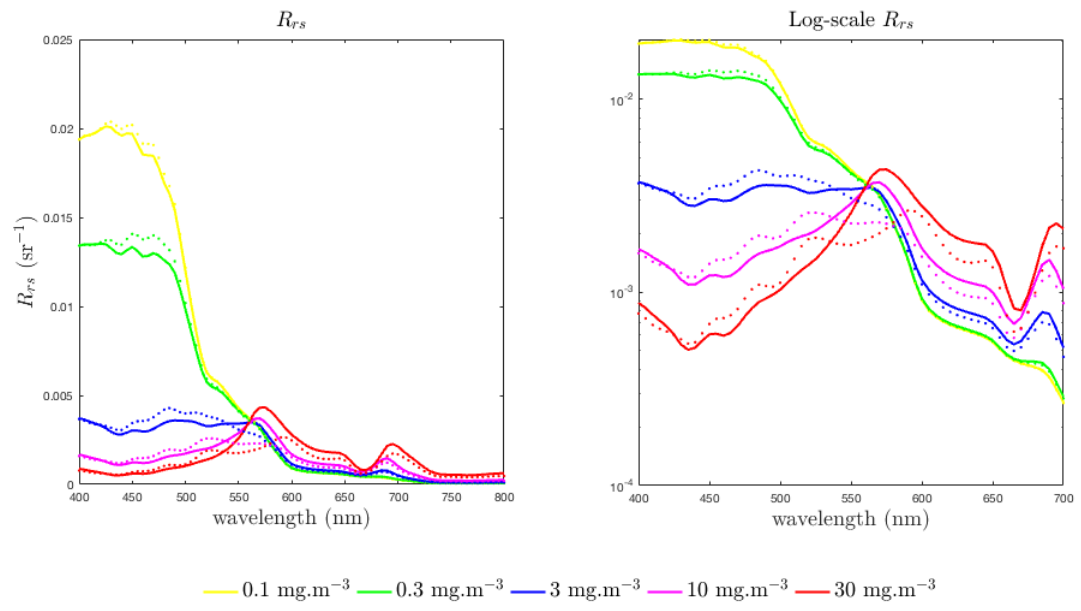
Figure 7. Benguela-like pigment-based experiment: Modelled R rs shown for Chl a -carotenoid pigmented assemblages (solid lines) and phycoerythrin containing assemblages (dotted lines) for identical Chl a concentrations, at 0.1, 0.3, 3, 10 and 30 mg · m − 3 . There is no change in D ef f , both are 12 µ m. The non-algal optical constituents are modelled with a gd ( 400 ) = 0.07 ∗ [ Chl a ] 0.75 , and b bnap ( 550 ) = 0.005 m − 1 .